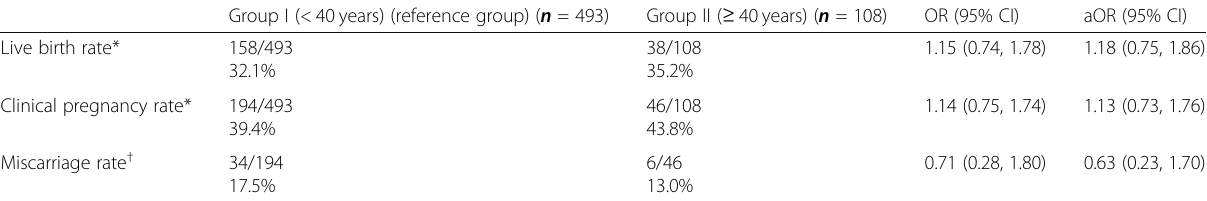
Table 5 Subgroup analysis: comparison of clinical outcomes between group I (male partner age < 40 years) and group II (male partner ≥ years) in women ≤ 35